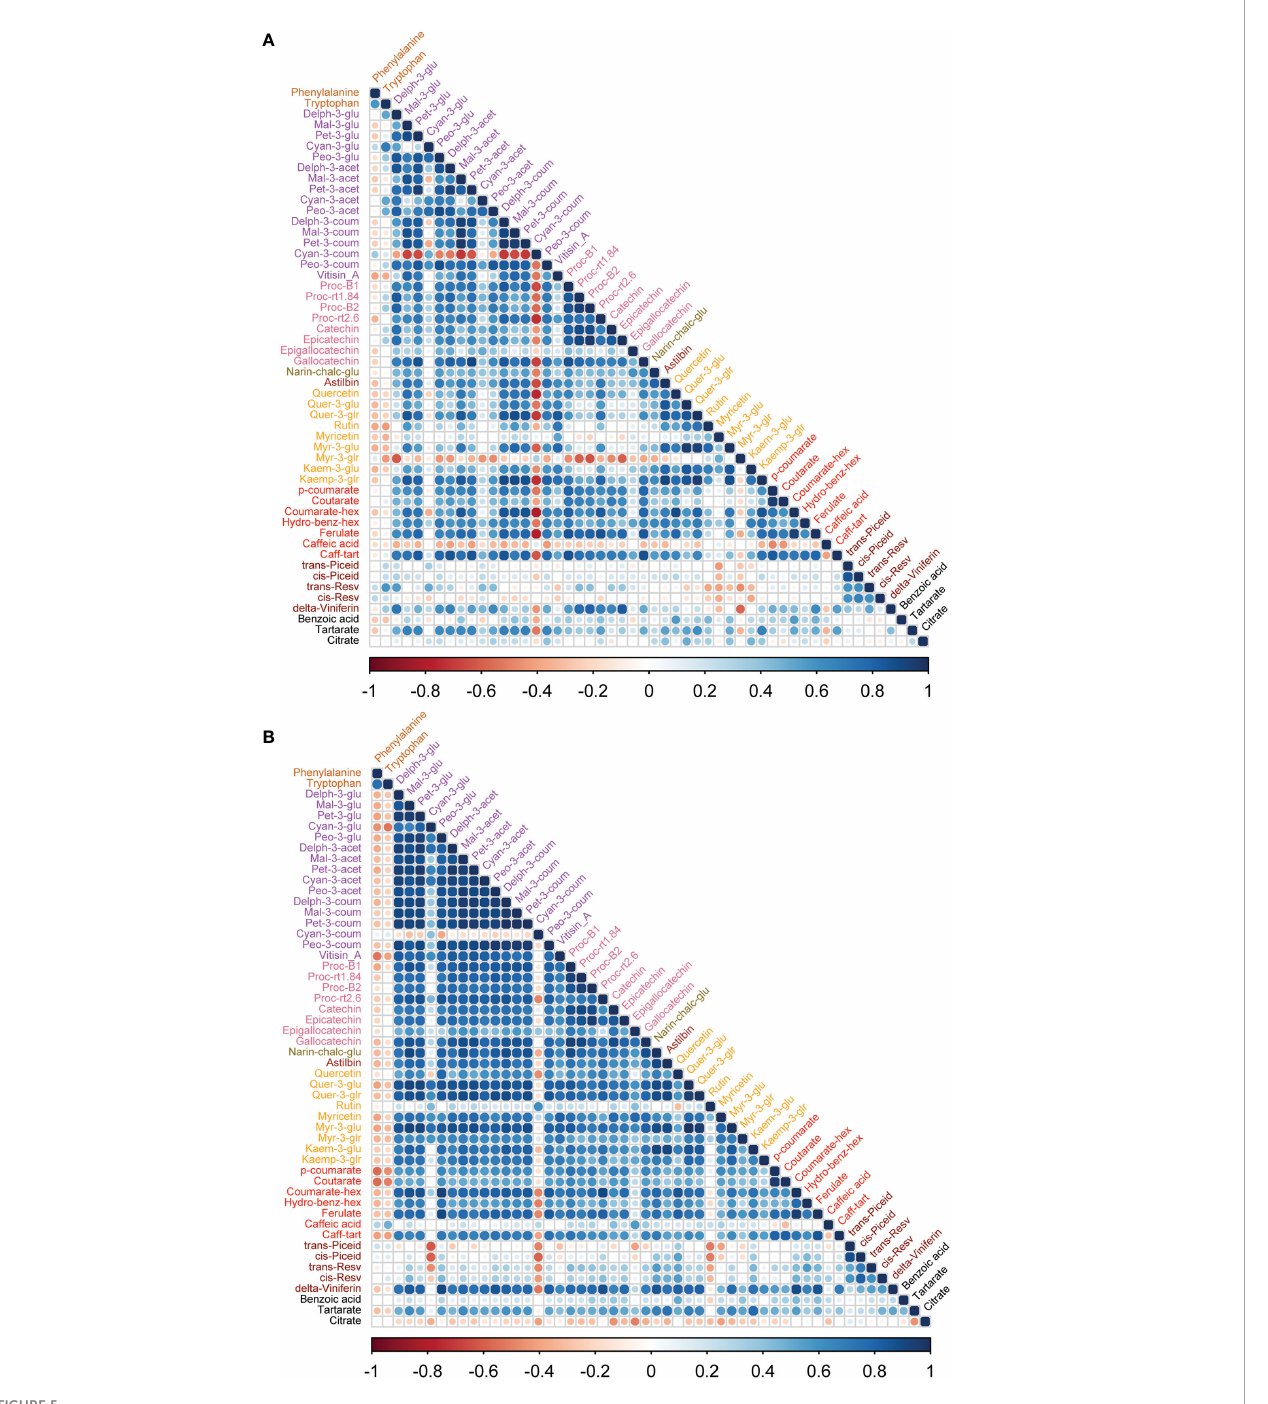
FIGURE 5 Correlation analyses between metabolites of wine samples from two cultivars. (A) In Syrah wine, most of the metabolites were positively correlated except cyan-3-coum, myr-3-glr and caffeic acid, which were negatively correlated. (B) In Malbec wine, most of the metabolites were positively correlated except cyan-3-coum, and citrate which were negatively correlated while rutin, caffeic acid, trans-piceid, cis-piceid, and benzoic acid had a weak correlation with other metabolites. Amino acids, phenylalanine and tryptophan were negatively correlated with most of the metabolites except trans-resv, cis-resv in Syrah wine, while caffeic acid, trans-piceid, and cis-piceid in Malbec wine showed a positive correlation with amino